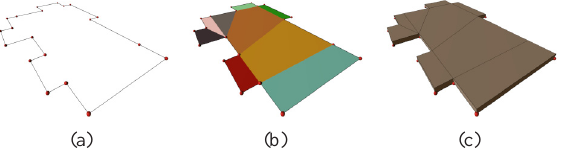
Figure 8: Floor slab construction . A simple polygon (a) is decomposed into convex parts that are extruded (b) to obtain the floor slab parts of the building (c).